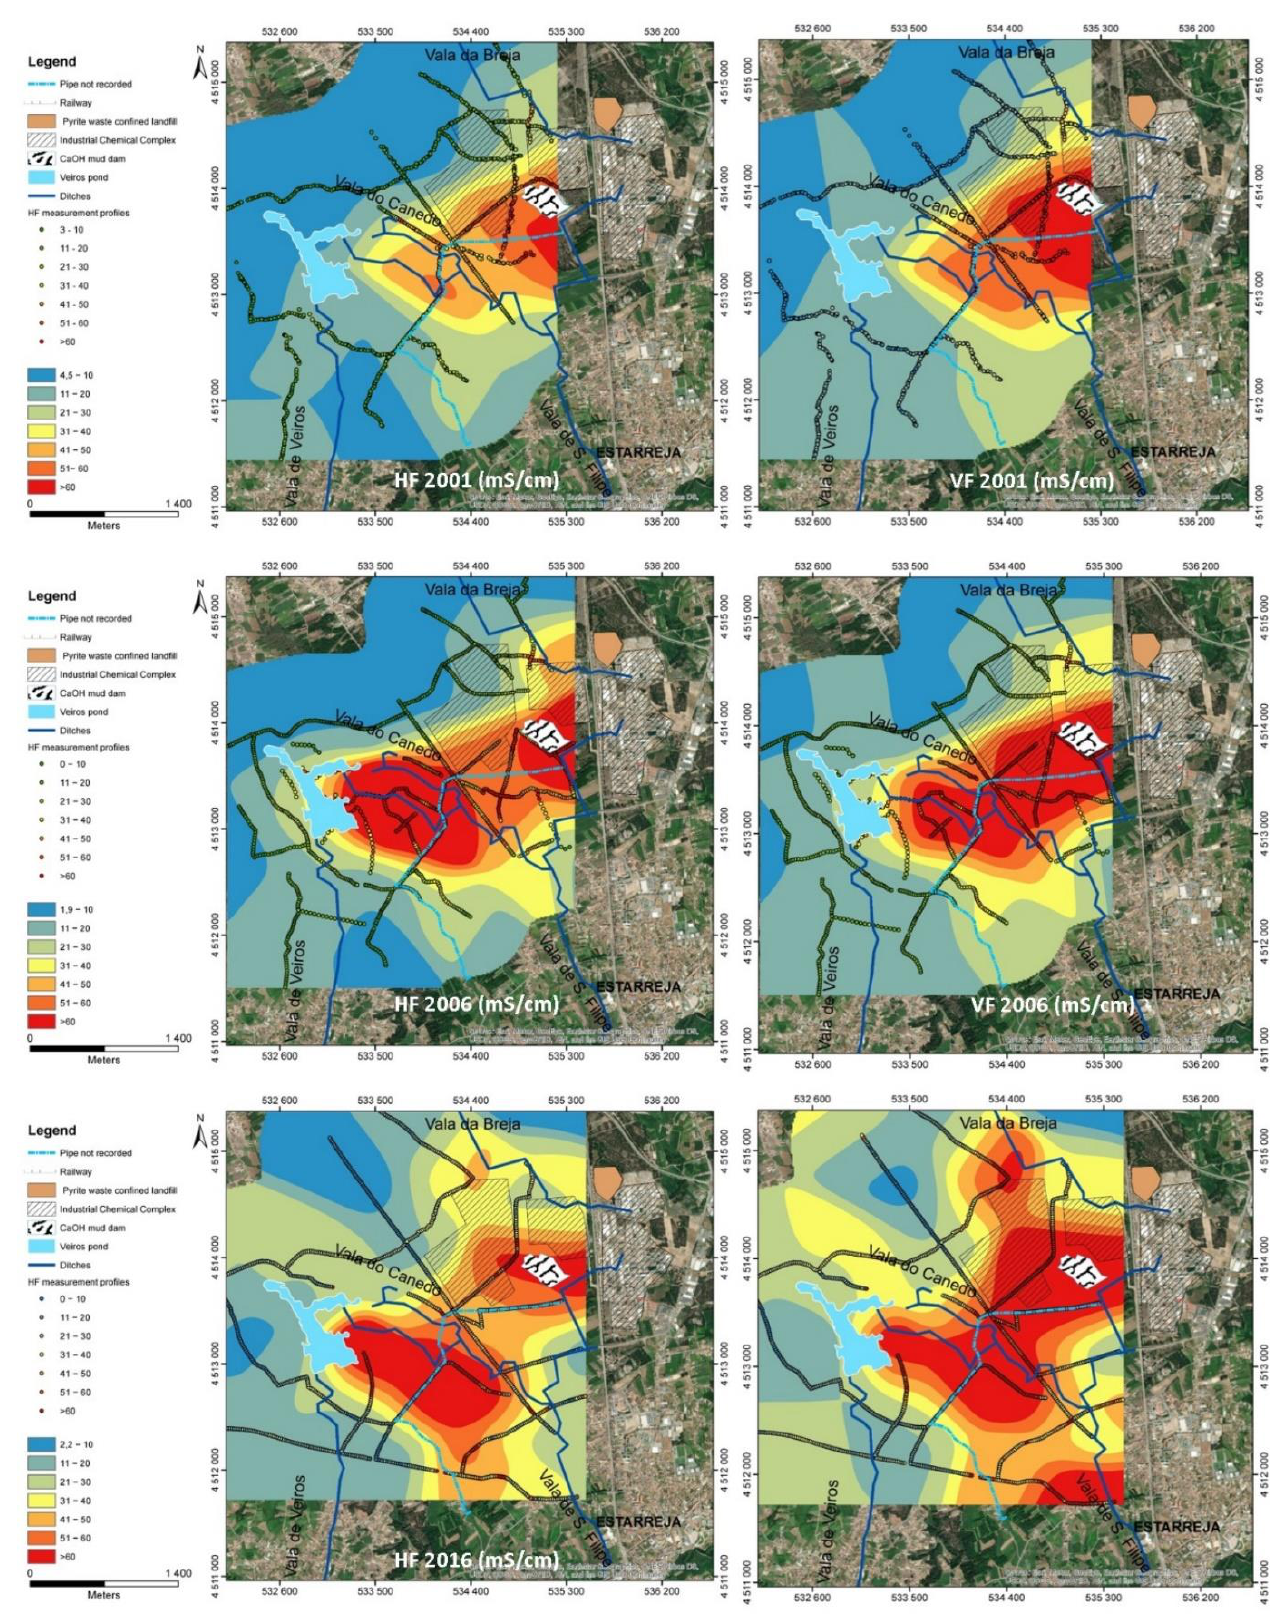
Figure 4. Electrical conductivity maps from 2001, 2006, and 2016 obtained through electromagnetic (EM34) methods. (HF—horizontal fields on the left; VF—vertical fields on the right). Map coordinates: UTM; WGS84—29N